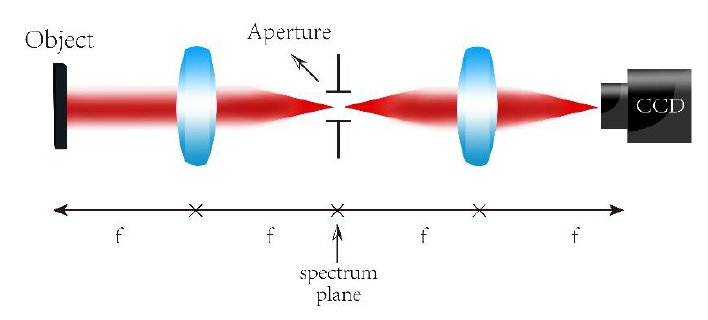
Figure 1. Classic 4f optical system. Two lenses with focal length f are required.